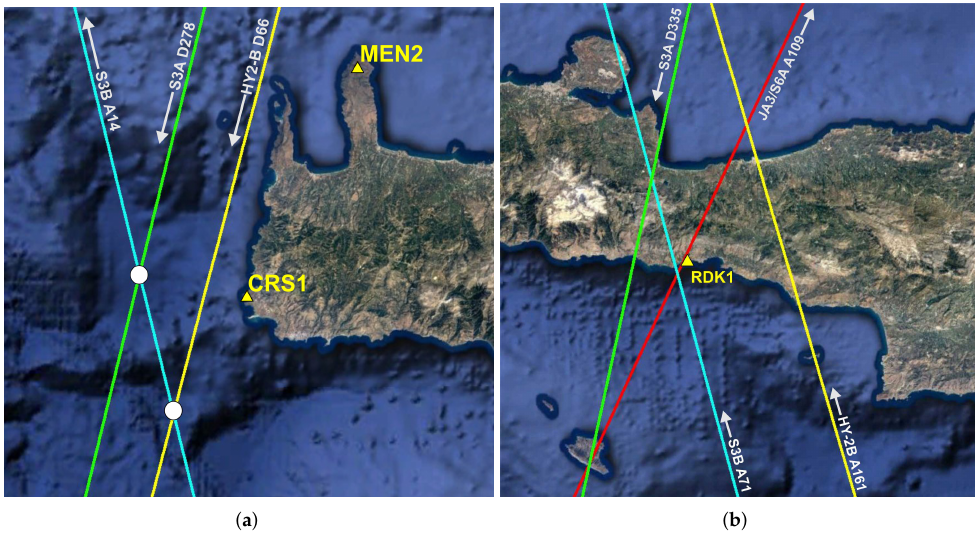
Figure 2. Supported satellites for calibration and their groundtracks around the CRS1 (southwest of Crete) and RDK1 (South Crete) Cal/Val sites. The left ( a ) shows the descending pass No. 66, while the right ( b ) displays the ascending pass No. 161 of HY-2B over west Crete along with Sentinel-3A and Sentinel-3B passes.